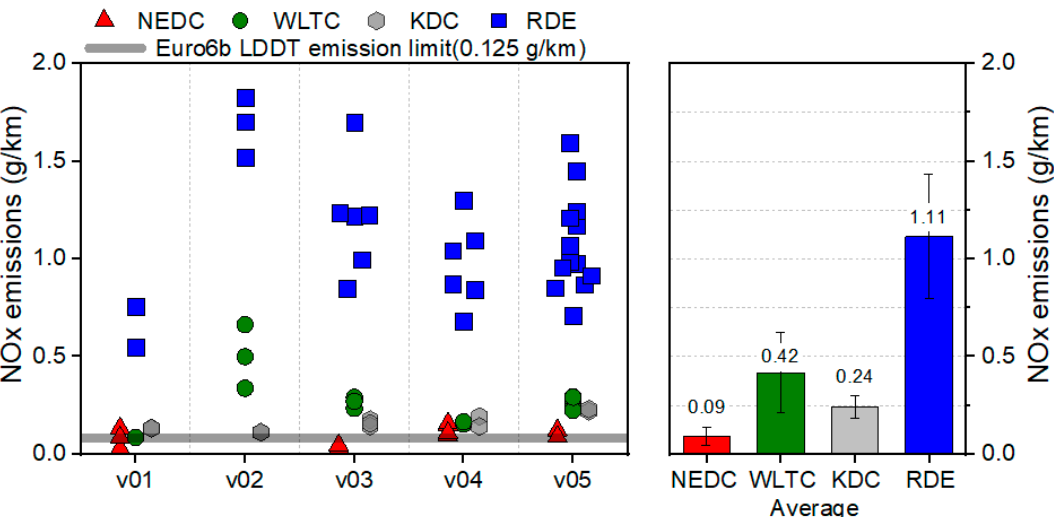
Figure 5. Results of average NOx emissions for each test vehicle under laboratory tests (NEDC: New European Driving Cycle, WLTC: worldwide harmonized light-duty vehicle test cycle, and KDC: Korea Driving Cycle) and Real Driving Emissions (RDE) tests. The error bars express the standard deviations.